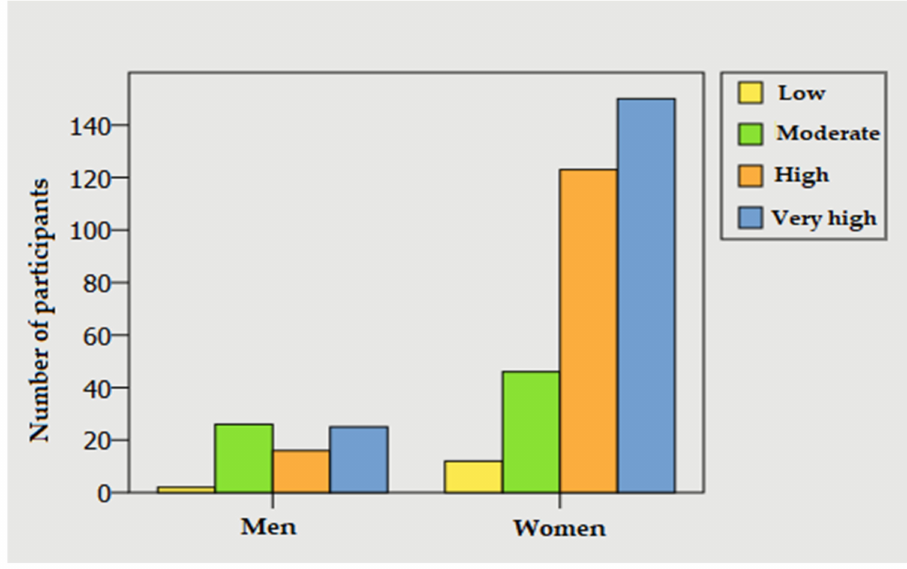
Figure 2. Frequencies in K-10 based on